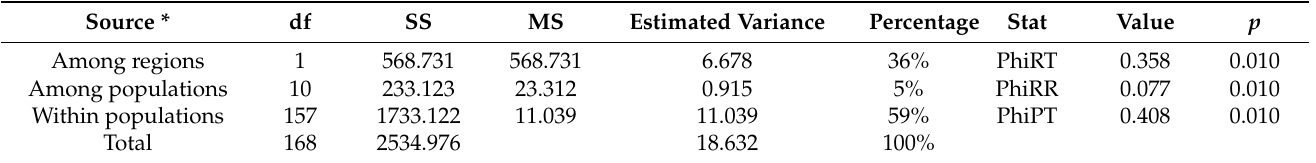
Table 6. Analysis of molecular variance (AMOVA) within and among 12 populations of Cylindrocarpon -like